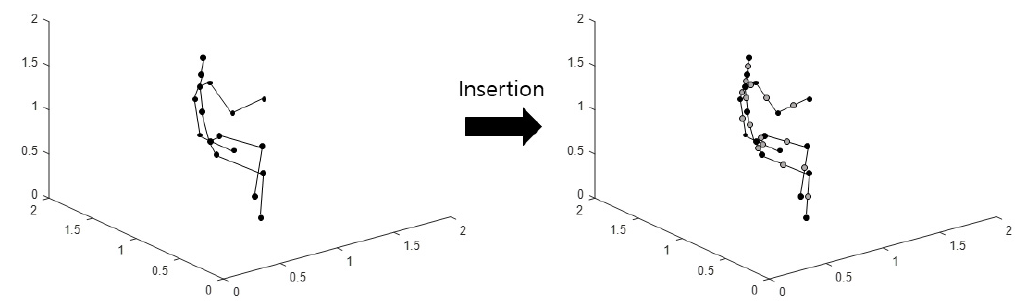
Figure 4. Schematic diagram of skeleton joint insertion.